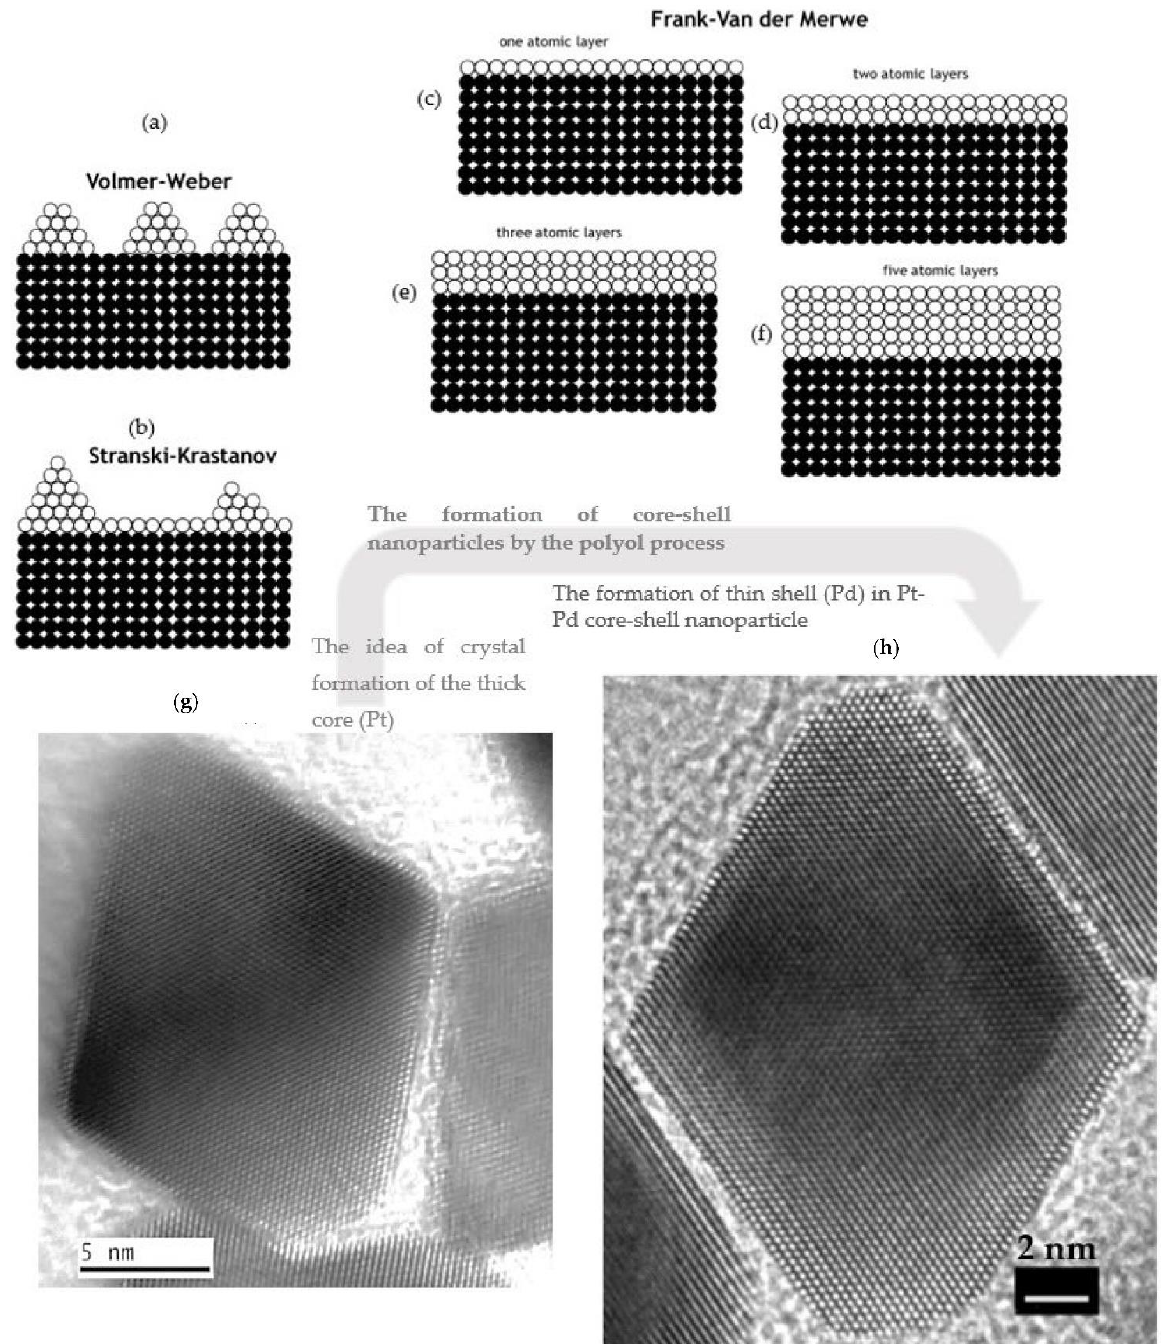
Figure 6. ( a – f ) To explain the crystal formation of core-shell structure, the mechanisms, growth, and formation of the thin shell in the shell-core bimetallic nanostructures include Vomer-Weber, Frank-Van der Merwe, and Stranski-Krastanov [27]. ( g ) The crystal core is Pt nanoparticle, exhibiting its crystal surface [38]. ( h ) The thin crystal shell shows several atomic monolayers of 1–3 nm. The Pd-based PGM thin shell with one atomic monolayer is a challenge to surface science, which is the limitation in bottom-up and top-down synthetic processes.